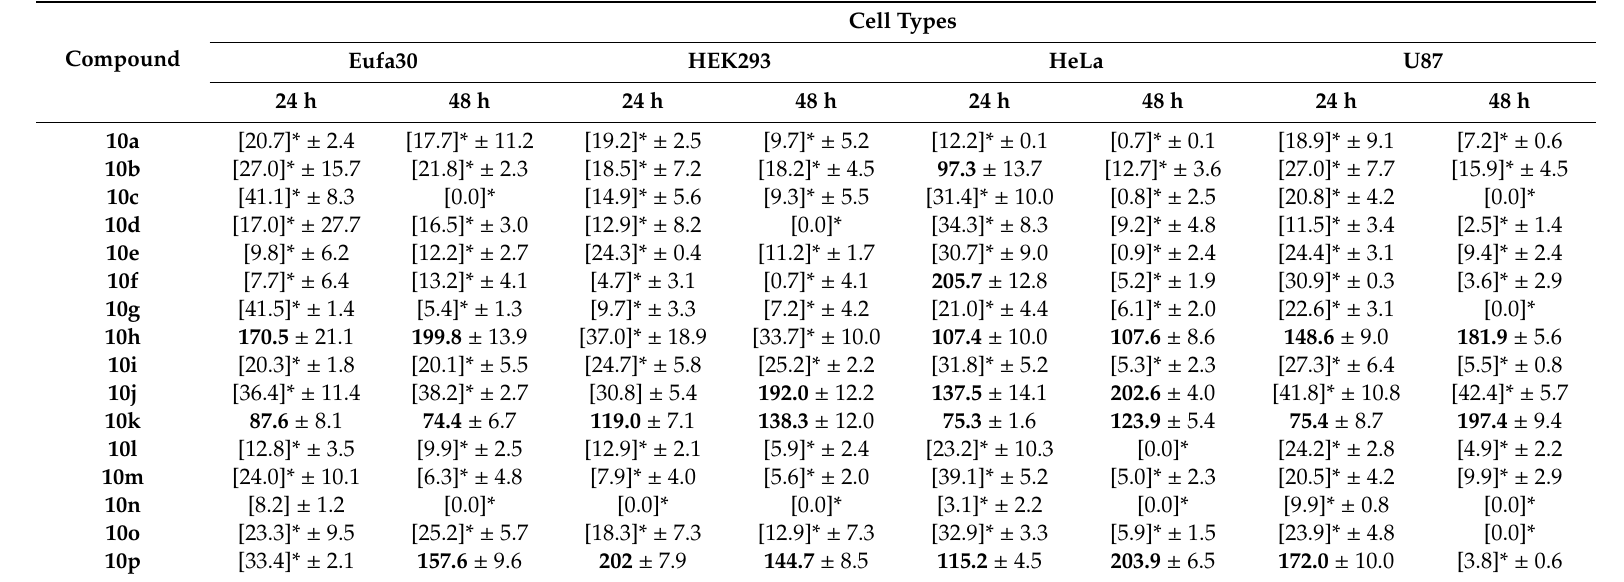
Table 2. IC 50 ( µ M) of dibenzo[ b , f ][1,5]diazocine-6,12-diones 10a–p based on the survival of non-cancerous (HEK293, EUFA30) and cancerous (U87, HeLa) cells after 24 and 48 h of treatment. “*”-Proliferation inhibition at 200 µ M, the highest concentration